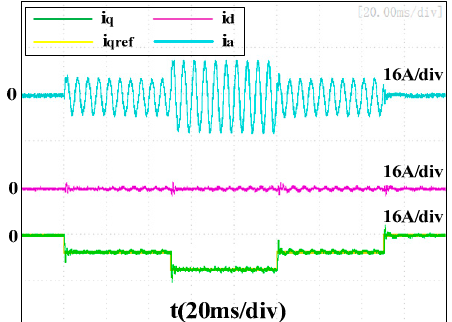
Figure 21. d-q axis current waveform of the current controller with feedback decoupling at 12,000 rpm with Kp = 1000 π Ls.